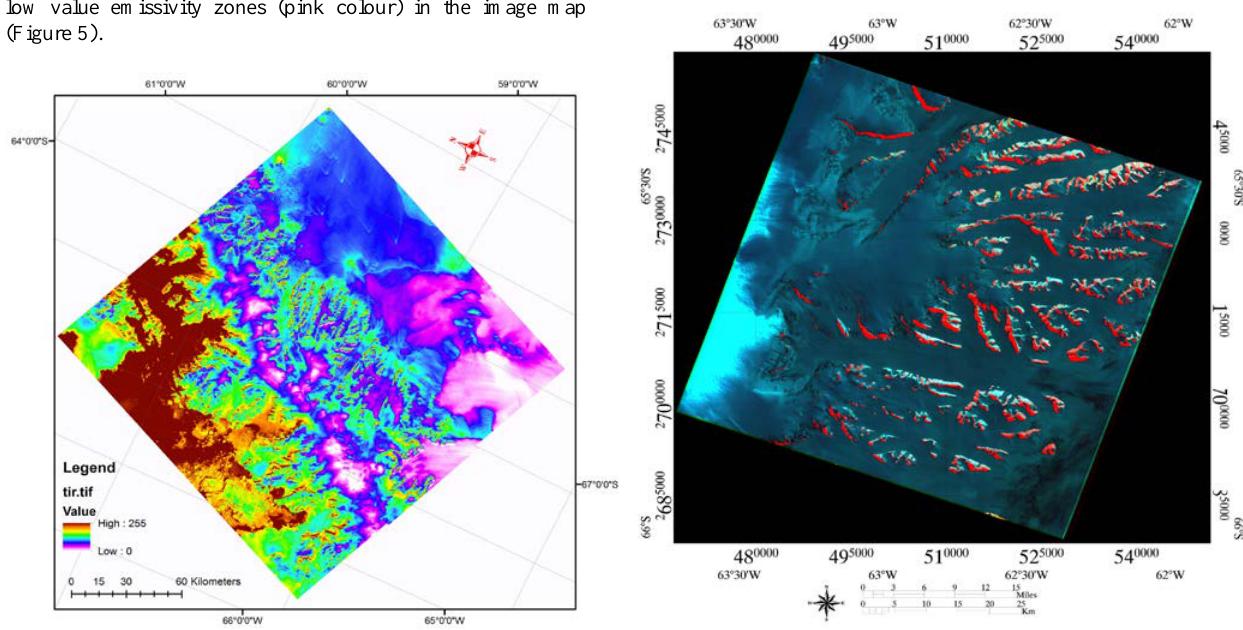
Figure 5. Image map of TIR bands+SWIR band of Landsat-8 for eastern segment of Graham Land. RGB color combination image was produced from band 10, 11 and 7 of Landsat-8.